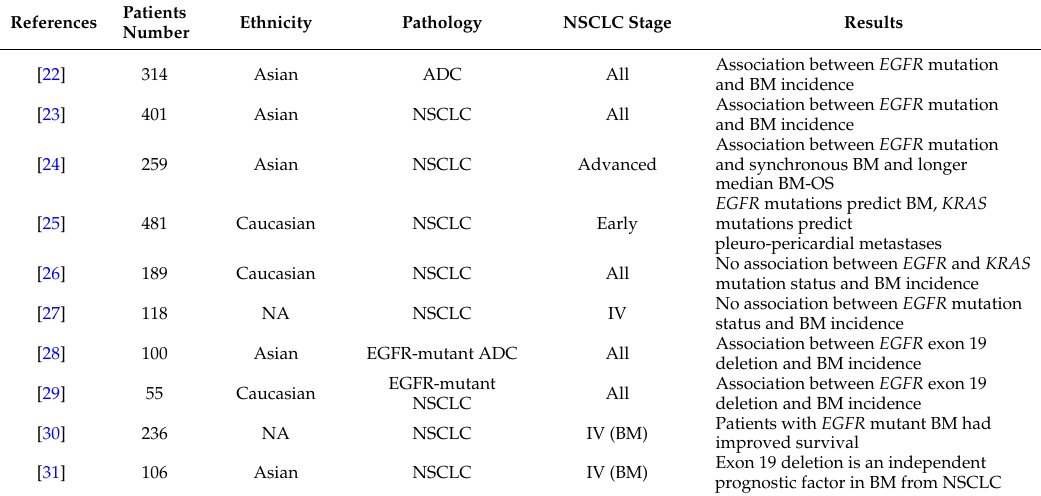
Table 6. Case series assessing the association of molecular profile with NSCLC BM. NSCLC =